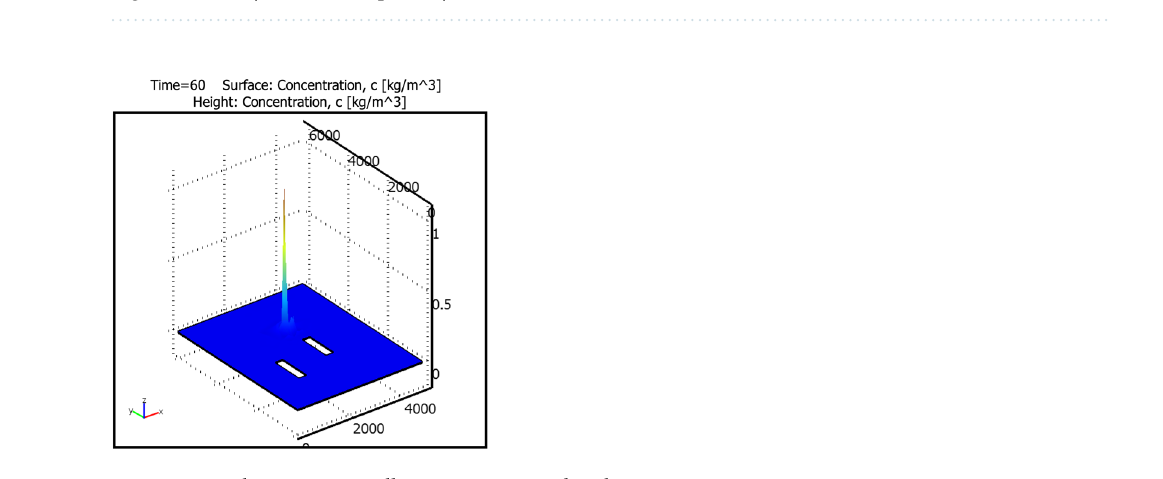
Figure 3. Rocky Mountain aquifer hydraulic head distribution.